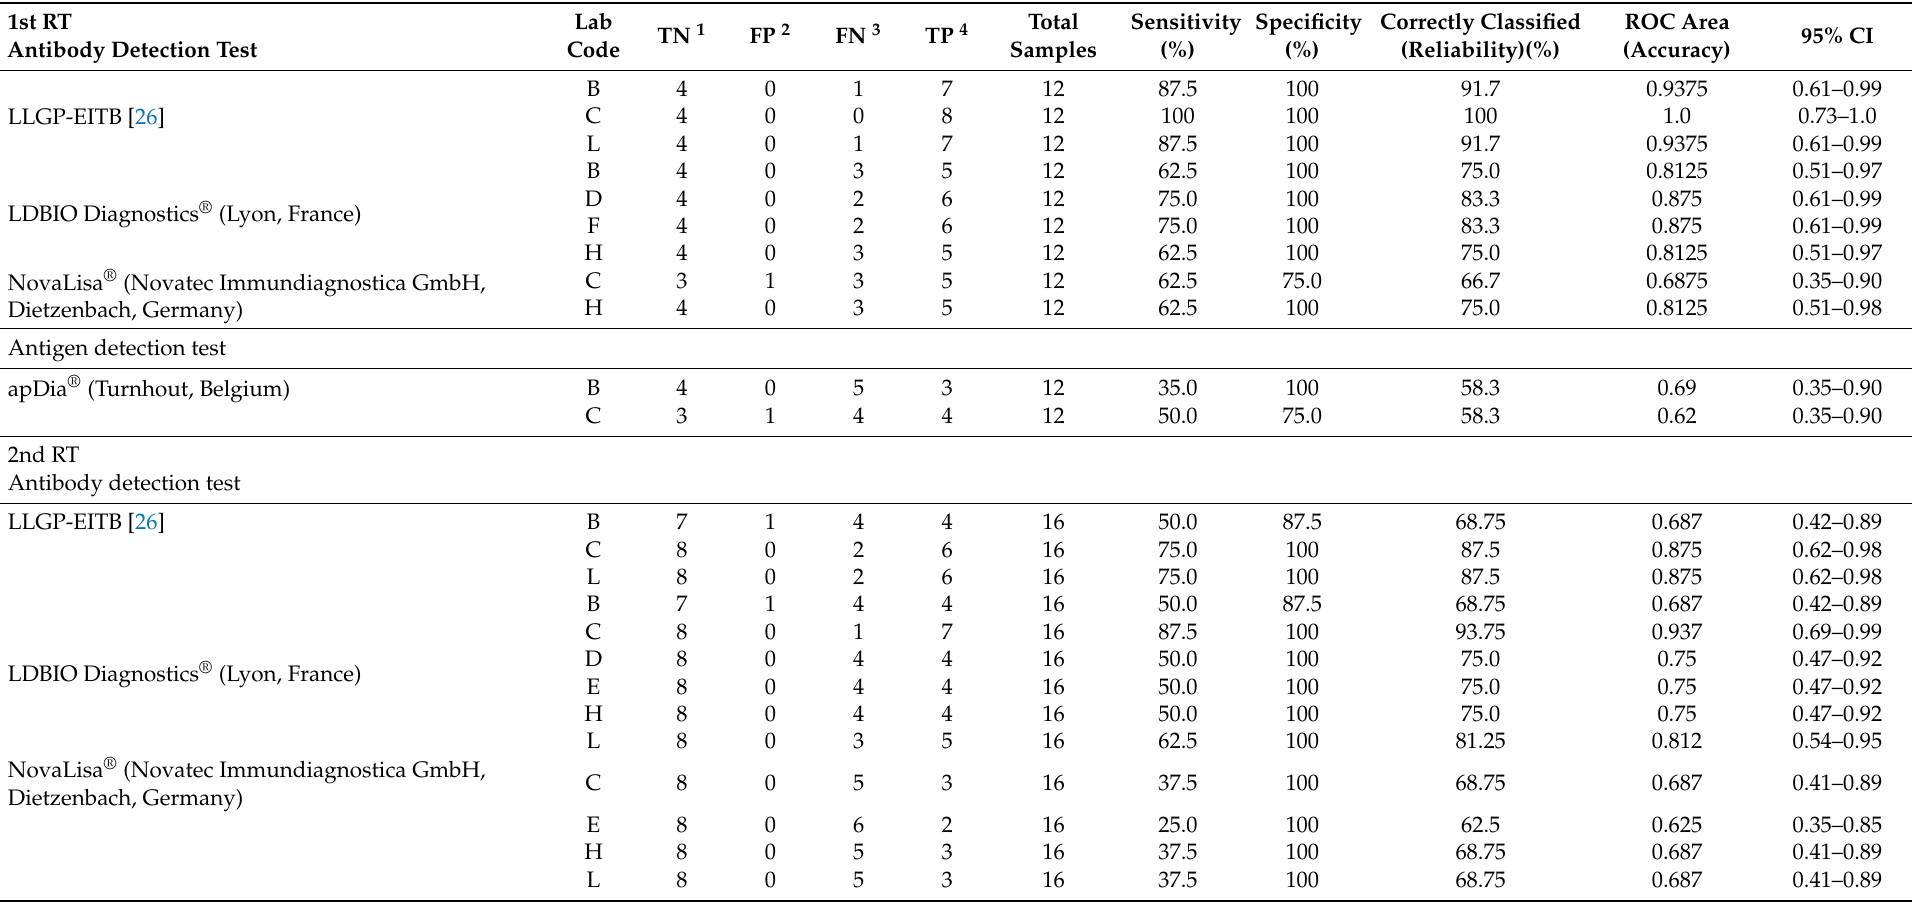
Table 6. Diagnostic accuracy by laboratory and test of the first and second Ring Trials